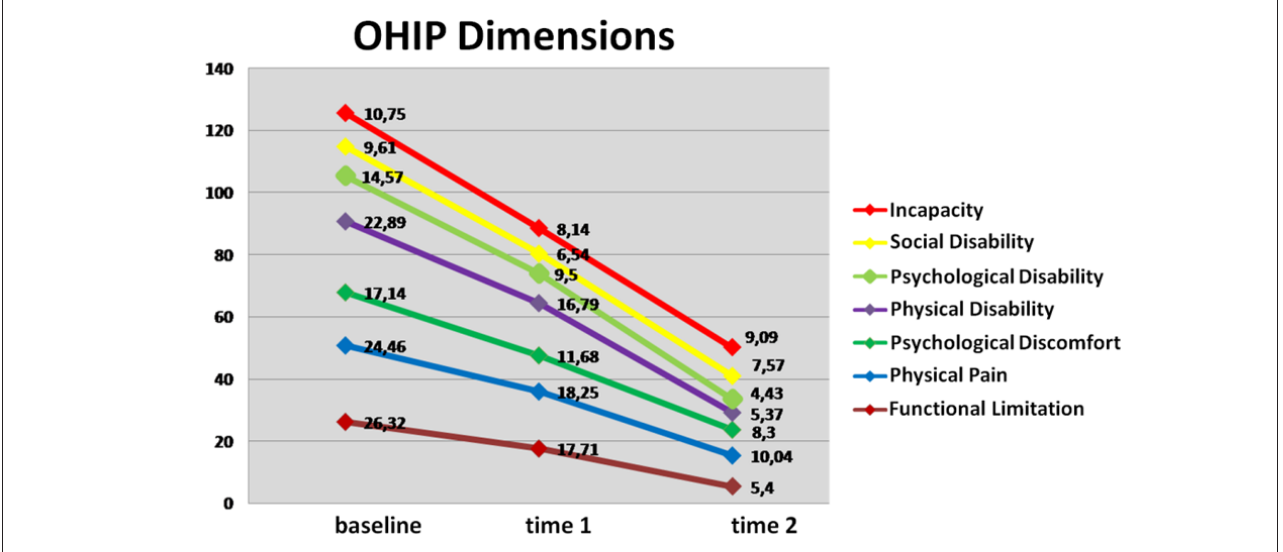
Fig. 2. Mean OHIP dimension values in relation to time: before (baseline), after 3 months (time 1) and after 2 years (time 2) of removable partial denture use.